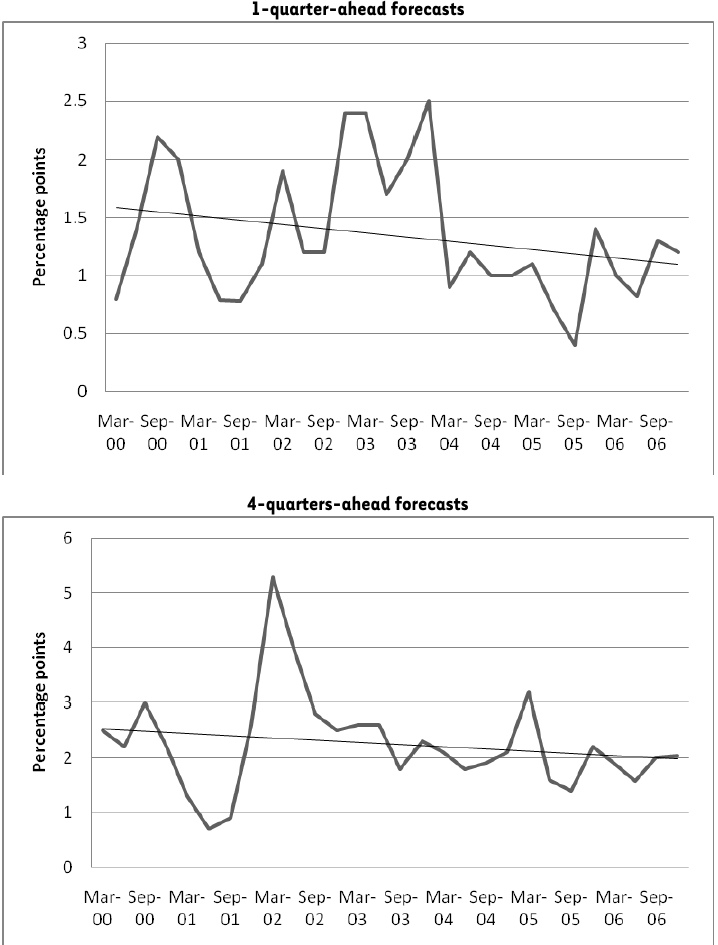
FIGURE 10: Dispersion in inflation forecasts, 2000-2006 1-quarter-ahead